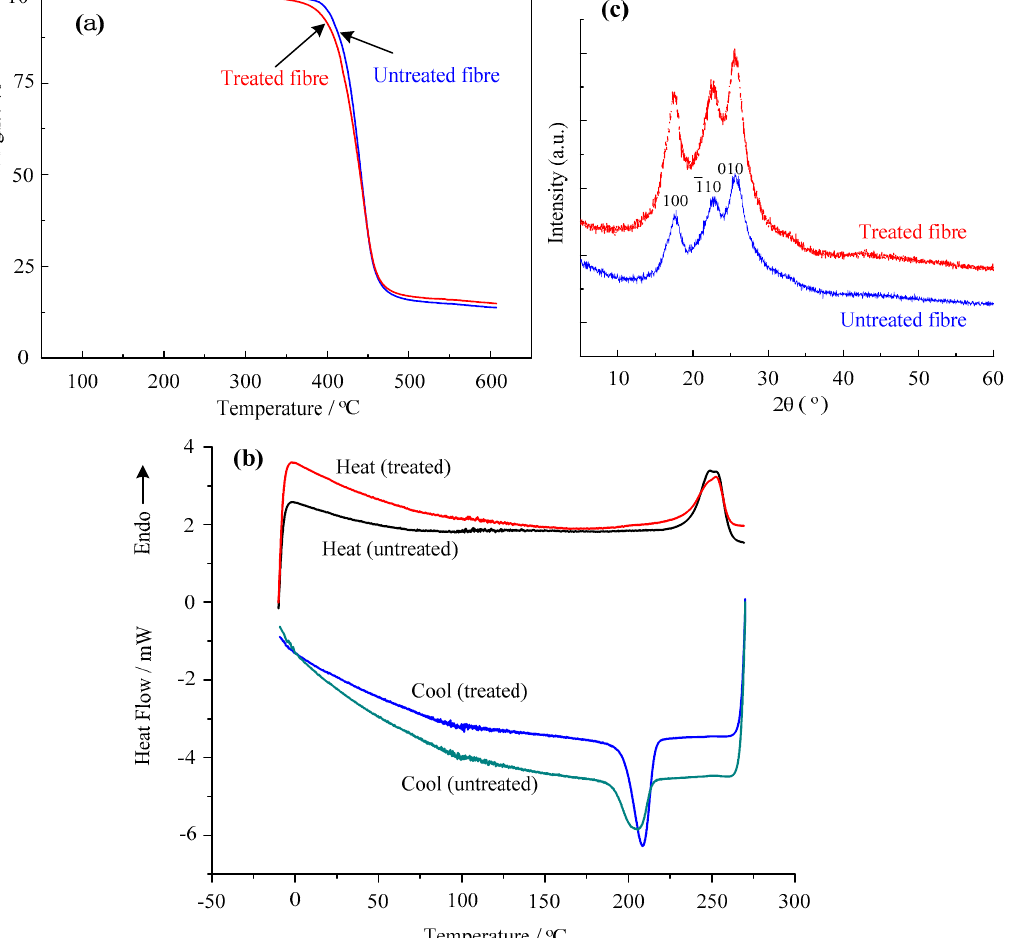
Figure 7. Thermogravimetric analysis (TG), differential scanning calorimetry (DSC), and X-ray diffraction (XRD) of untreated and treated PET fabrics. ( a ) Thermodynamic analysis, ( b ) DSC scanning diagrams, ( c ) XRD patterns.